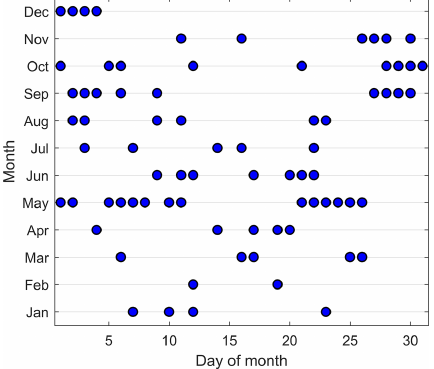
Figure 6. Dates between November 2007 and June 2016 (which is the coverage in the NOTCam archive) when the NOTCam was mounted at the NOT and making spectroscopic astronomical obser-